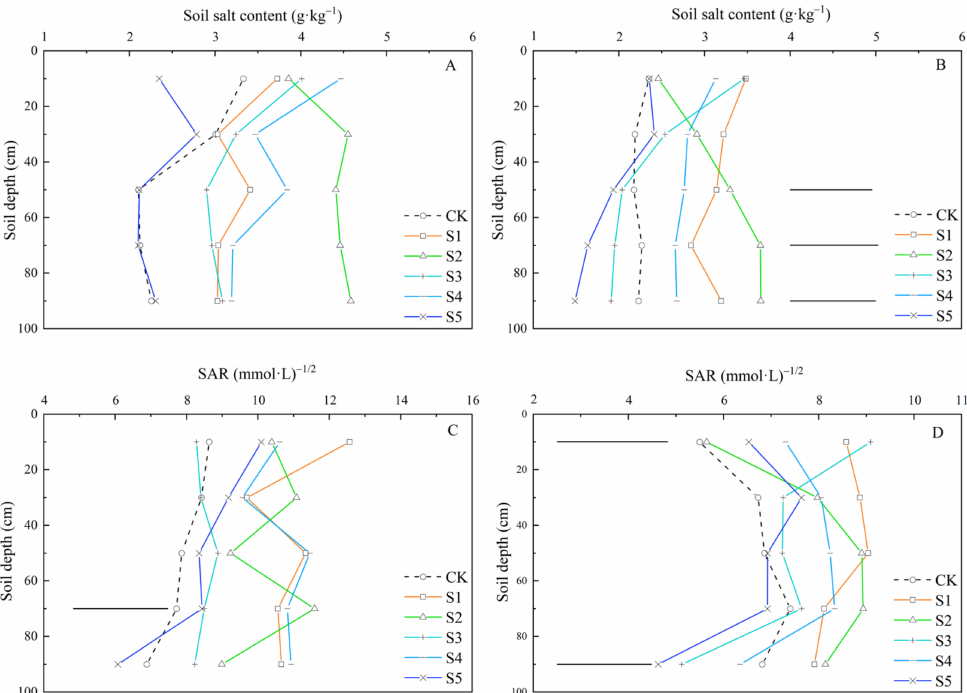
Figure 8. The salt content and sodium adsorption ratio of soil sampled before and after leaching. ( A , B ) represent the salt content in soil layers before and after leaching, respectively. ( C , D ) represent the sodium adsorption ratio in soil layers before and after leaching, respectively. The length of the horizontal line represents LSD ( p = 0.05) in the least significant difference method, and if there is no horizontal line, it means the analysis of variance is not significant. SAR refers to sodium adsorption